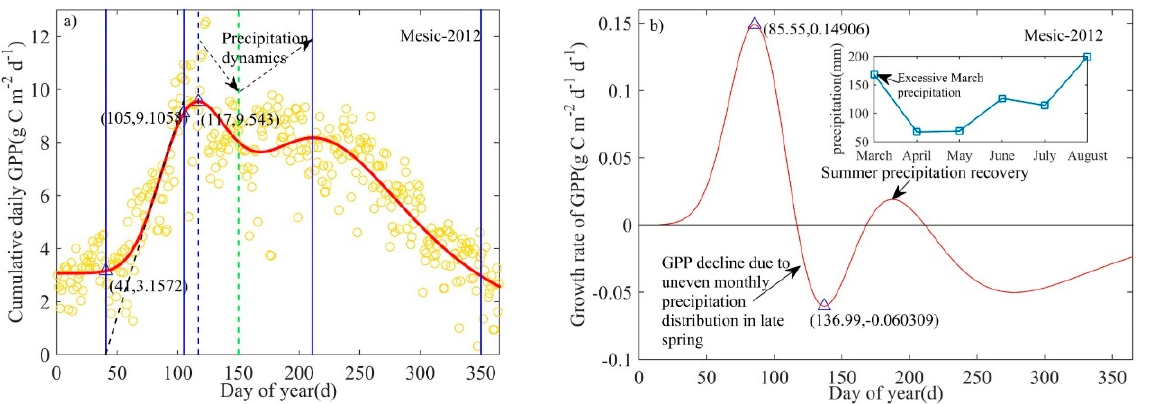
Figure A3. Effects of non-drought-related irregular spring rainfall on summer phenological process of mesic site in 2012. At 117 d in 2012, the mesic site started to have a significant decline in GPP (spring),